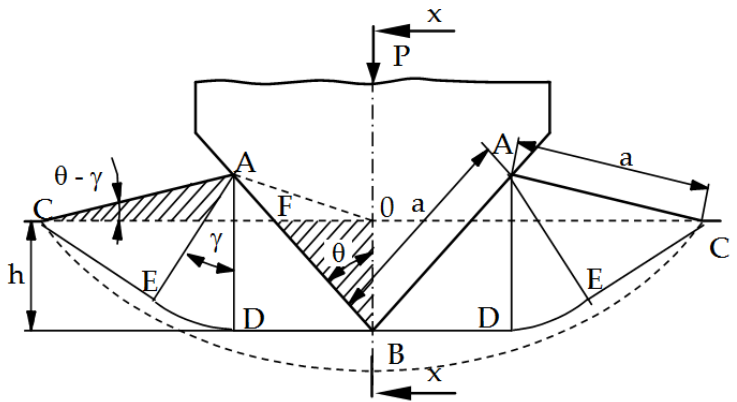
Figure 8. Scheme of deformation during insertion of wedge into plastic material [26].